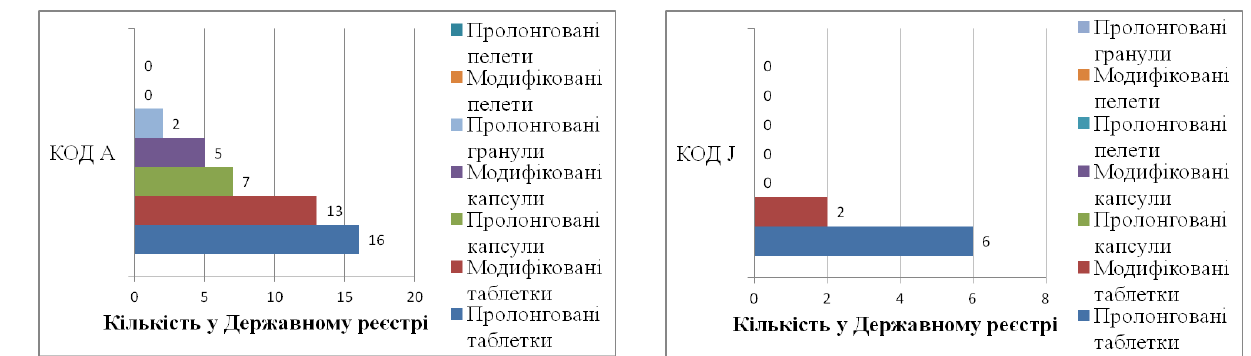
Рис. 5. Кількісна представленість ТОЛЗВД у Державному реєстрі (код A – Лікарські засоби, що впливають на травну систему та обмін речовин)